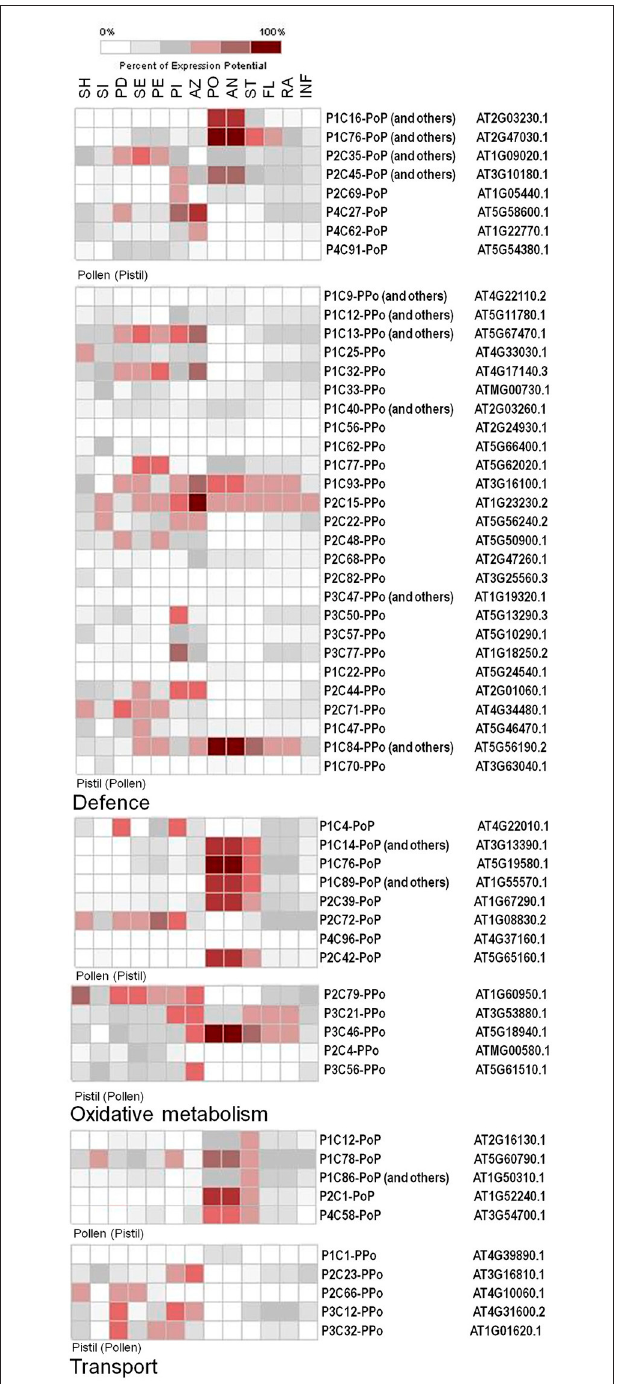
FIGURE 7 | Level of expression across several reproductive/vegetative tissues of genes considered putative homologs to Arabidopsis using the anatomy tool Genvestigator. Three categories were considered for analysis of the levels of expression: oxidative metabolism (upper part), defense (middle part), and transport (lower part). The transcripts of two selected libraries were considered only: Po(P) and P(Po). SH, shoot; SI, silique; PD, pedicel; SE, sepal; PE, petal; PI, pistil; AZ, abcision zone; PO, pollen; AN, anther; ST, stamen; FL, flower; RA, raceme; INF, inflorescence. Identities of both the olive SSH transcripts and their corresponding Arabidospsis homologous are shown for reference